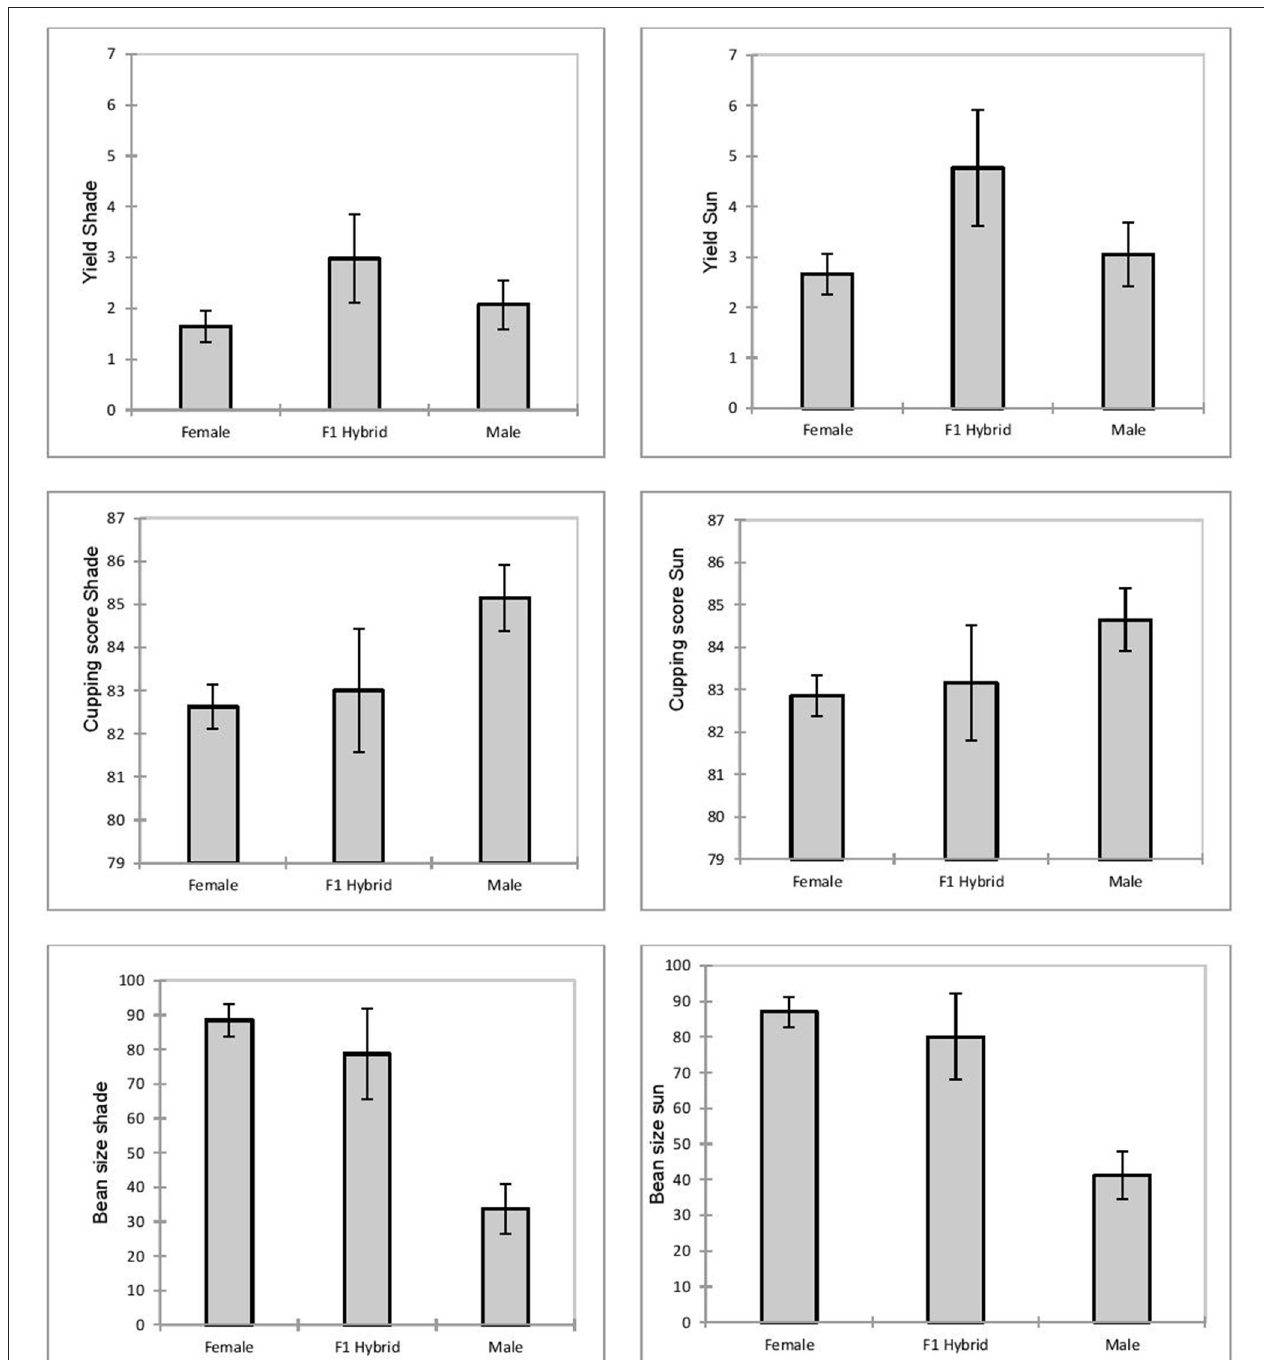
FIGURE 1 | Comparison of yield (expressed as kg of green coffee beans per plant), final cupping score (out of 100), bean size (percentage of bean size 16–20), in female, male and F1 hybrids in shade and full-sun plots.